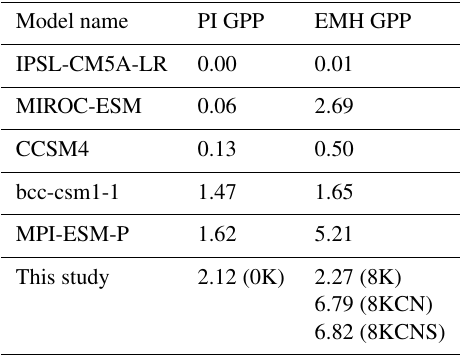
Table 5. GPP (gCm − 2 per month) from five CMIP5 models